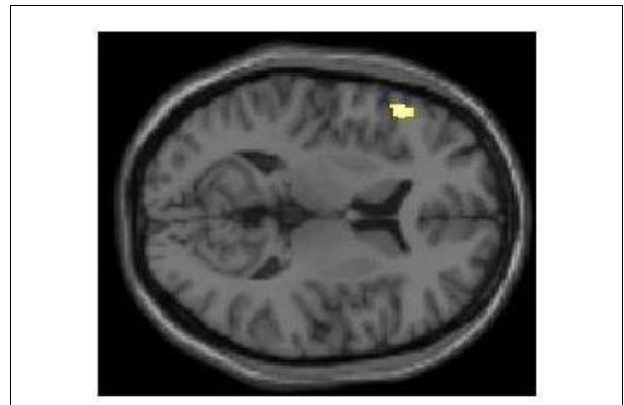
FIGURE 3 | Following sleep deprivation the left inferior frontal gyrus was activated more when generating uses (fluency) in the divergent thinking task. Following sleep deprivation, there was greater activation in left inferior frontal gyrus when generating uses (compared to recalling characteristics) in the Alternate UsesTask. SPM rendered into standard stereotactic space and superimposed on to transverse MRI in standard